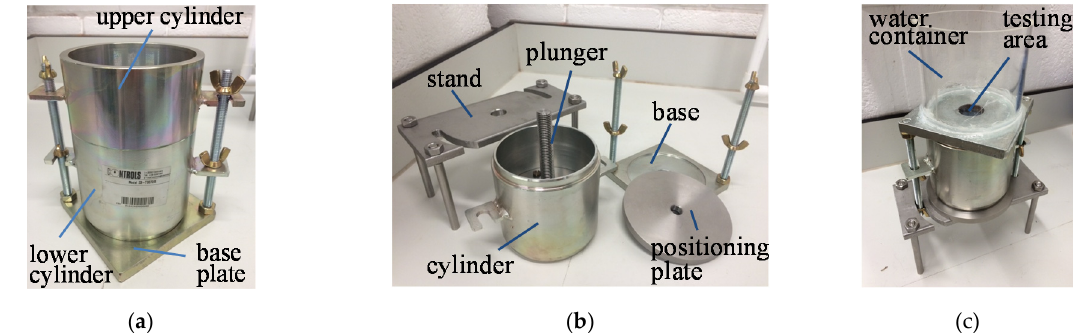
Figure 7. Test cell design, ( a ) BS standard compaction test mold (1 Litre, BS 1377, inner diameter 105 mm, wall thickness 4.5 mm), ( b ) disassembly elements of test cell, ( c ) test cell after assembly.